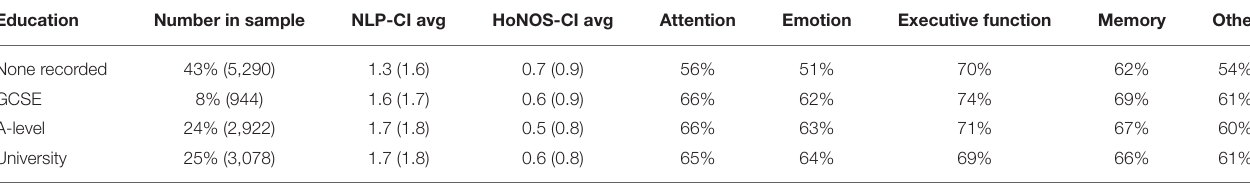
TABLE 4 | Prevalence of different NLP-CI symptoms grouped by